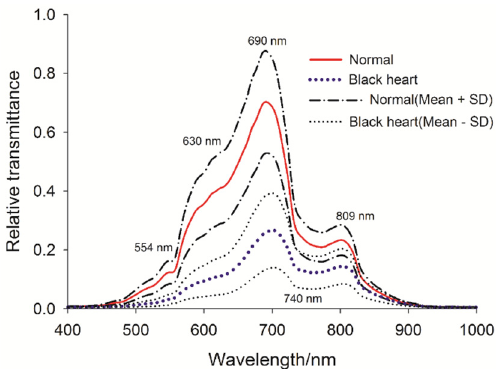
Figure 3. Mean relative transmittance spectra and standard deviation (SD) calculated from the regions of interest (ROIs) of all the normal and defective white radishes.